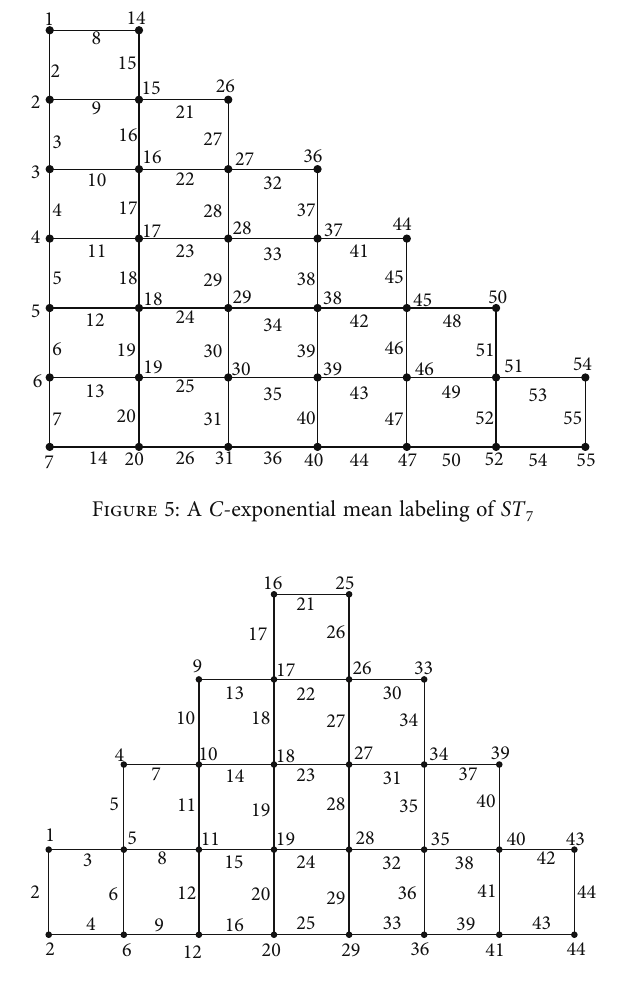
Figure 6: A C -exponential mean labeling of 2 ST